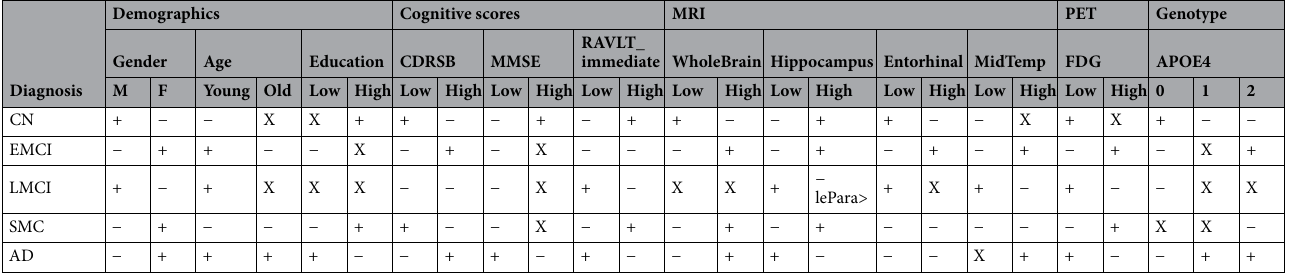
Table 5. XGBoost global interpretability.